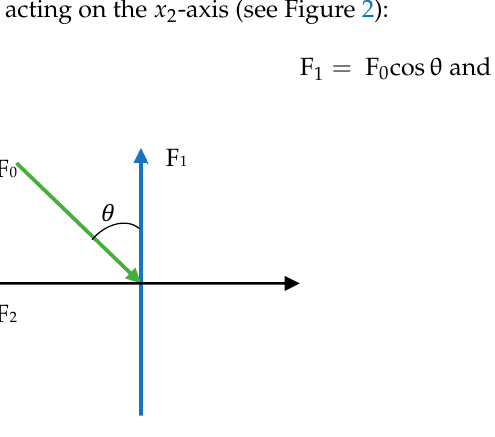
Figure 2. Inclined load over a fiber-reinforced thermoelastic solid.